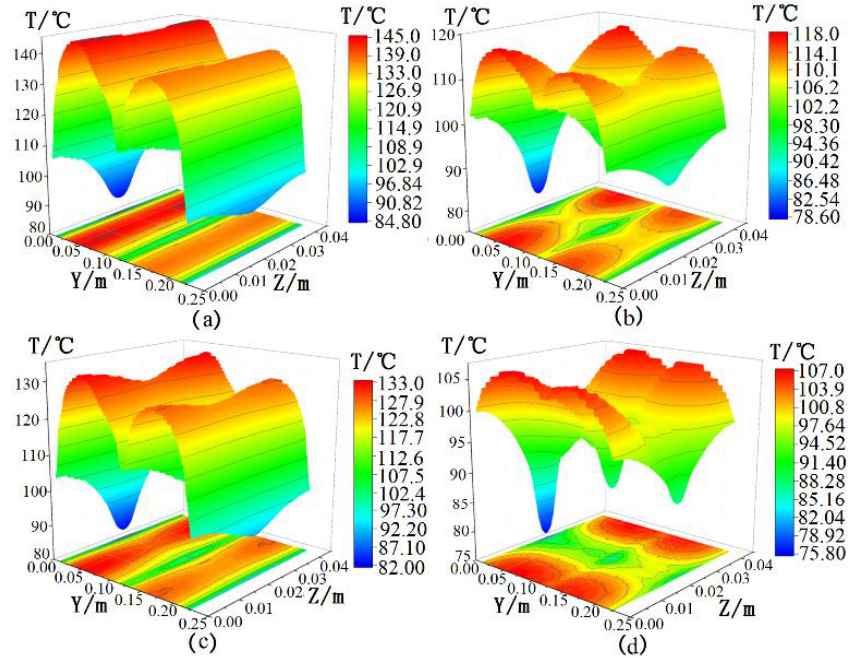
Figure 8. The main insulation axis–radial temperature distribution in the un-shelling side in the stator main insulation unilateral shelling δ = 1.0 mm: ( a ) The main insulation axial–radial P 17 temperature distribution; ( b ) The main insulation axial–radial P 18 temperature distribution; ( c ) The main insulation axial–radial P 19 temperature distribution; ( d ) The main insulation axial–radial P 20 temperature distribution.